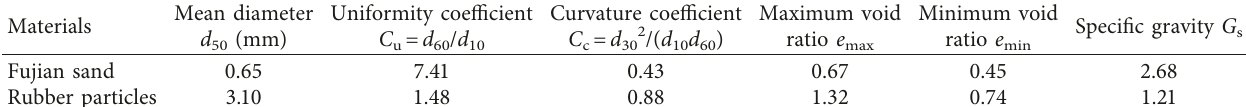
Table 1: Physical properties of the Fujian sand and rubber particles used in the tests.